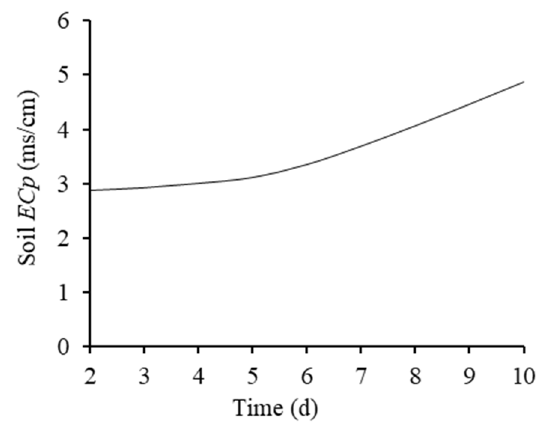
Figure 17. Changes in the EC p of soil at a depth of 40 cm in the non-control zone.